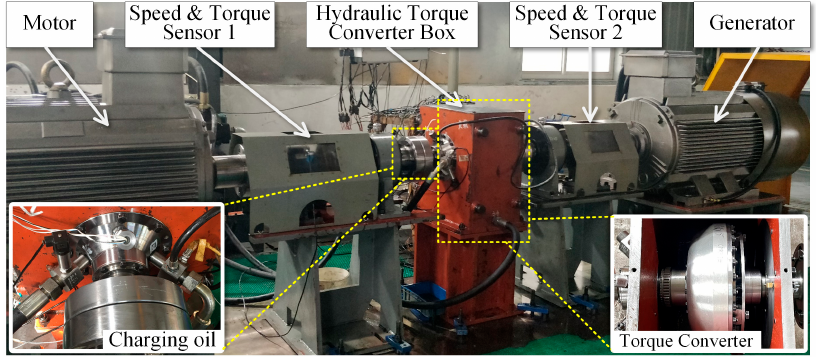
Figure 4. Torque converter test cell.